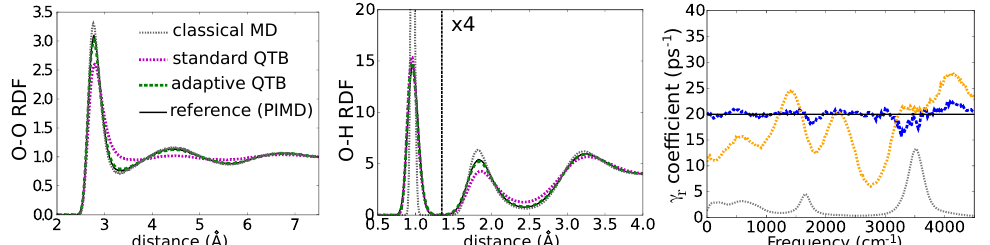
Figure 12. Radial distribution functions (RDF) in liquid water at 300 K described with the q-TIP4P/F model and simulated with different molecular dynamics methods (left, oxygen–oxygen; middle, oxygen–hydrogen). The friction coefficient used for QTB and adQTB methods is γ = 20 ps − 1 , the adapted random force coefficients γ r ( ω ) are plotted on the right panel for oxygen (dashed blue) and hydrogen (dotted orange) atoms. The simulations were performed using Tinker-HP software [81] and parameters similar to that in Ref.